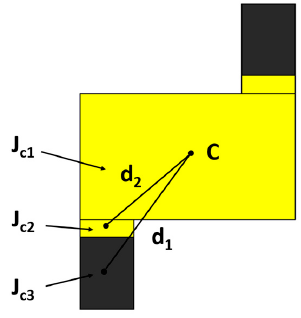
Figure 12. The moment of inertia of each part and the parallel axis theorem.